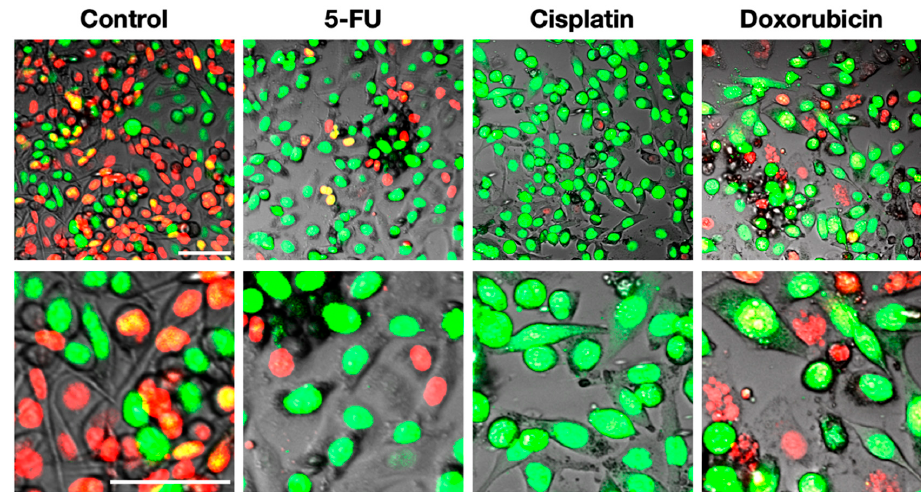
Figure 5. Representative images of responses of FUCCI HeLa cells to cytotoxic agents. FUCCI HeLa cancer cells were treated with 5 ‐ FU, cisplatinum, and doxorubicin. The cells in G 1 , early ‐ S, or late ‐ S/G 2 /M phases appear red, yellow, or green, respectively [32]. Scale bar; 100 μ m.